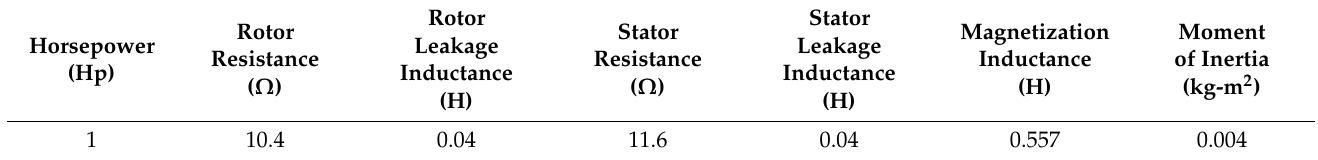
Table 11. Parameters of the three-phase induction motor.